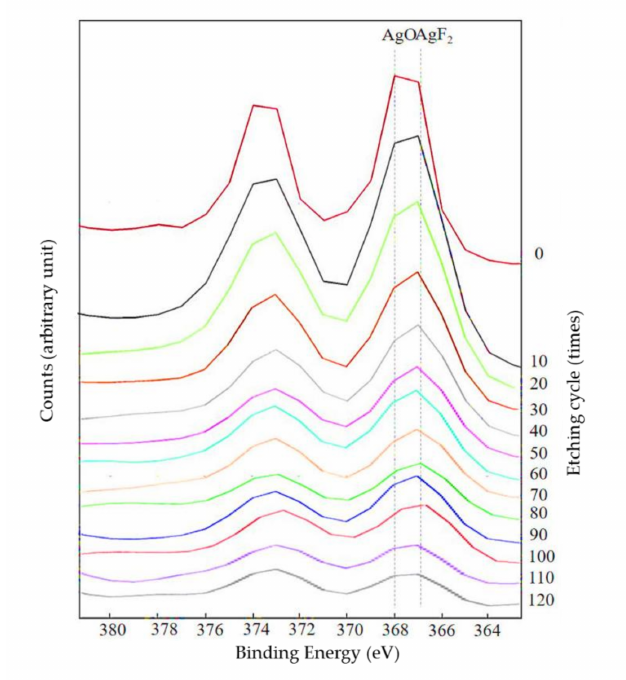
Figure 2. Ag3d depth profile spectra of Ar / F + Ag specimen. Separated peaks indicate AgO 368.0 eV and AgF 2 367.0 eV.